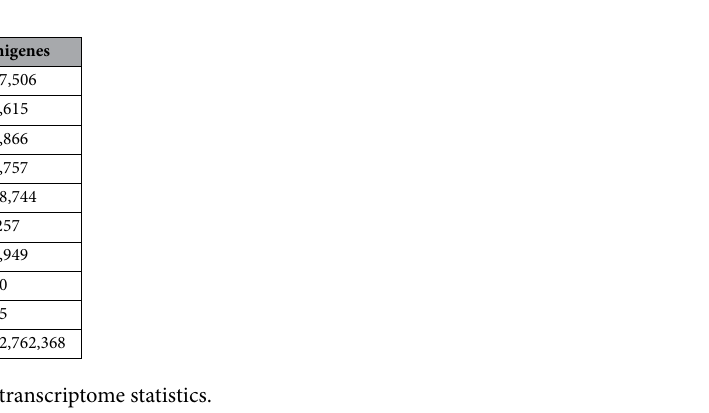
Figure 2. Assembly, mapping, and annotation of transcriptomes and differentially expressed genes (DEGs) between six comparisons of adjacent molting stages in Scylla paramamosain . ( A ) Average number of unigenes and number of genes with fragments per kilobase of exon per million mapped fragments (FPKM) ≥ 1; ( B ) total number of reads, number of reads mapped to the reference transcriptome, and number of reads mapped to the stage-specific transcriptome for each molting stage; ( C ) summary of unigenes annotated in different databases. NR NCBI non-redundant protein sequences, NT NCBI non-redundant nucleotide sequences, Pfam protein family, Swiss-Prot a manually annotated and reviewed protein sequence database, KOG Clusters of Orthologous Groups of proteins, GO Gene Ontology, KEGG Kyoto Encyclopedia of Genes and Genomes database, All total number of unigenes that were successfully annotated in at least one database; ( D ) DEGs between six comparisons of adjacent molting stages (InM-I vs PoM, InM-II vs InM-I, InM-III vs InM-II, InM-IV vs InM-III, PrM vs InM-IV, and PrM vs PoM). The number of up-regulated and down-regulated genes between comparisons is given. The x-axis indicates adjacent stages in comparisons. The y-axis indicates the number of DEGs.